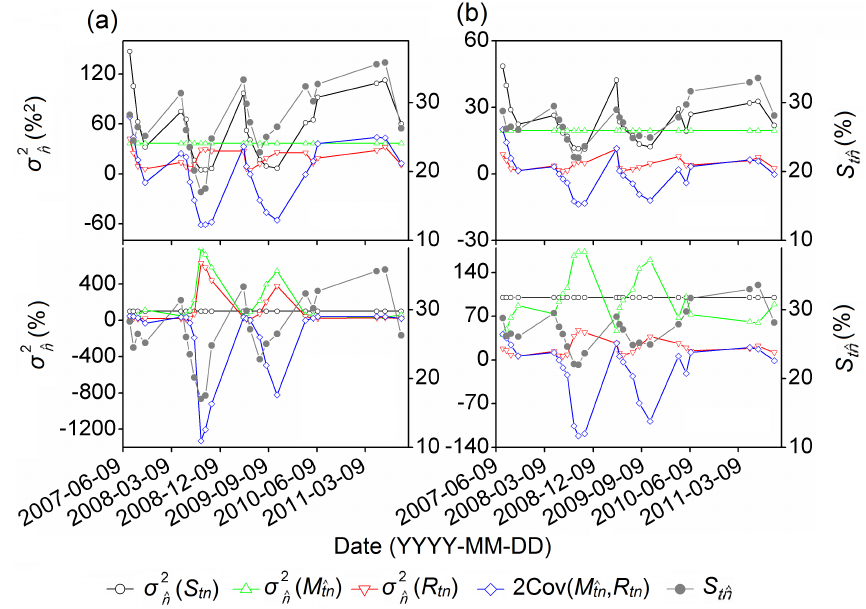
Figure 5. Spatial variances of different components in Eq. (8) expressed in % 2 (upper panel) and as percentage (lower panel) for (a) 0–0.2 and (b) 0–1.0m. Spatial mean soil water content S t ˆ n on each measurement day is also shown.